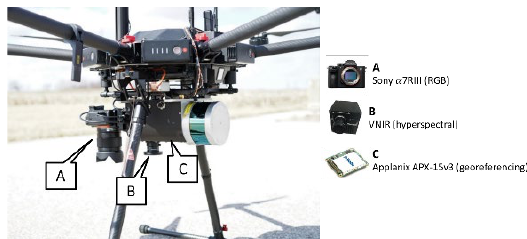
Figure 1. The UAV-based mobile mapping system and onboard sensors used in this study.